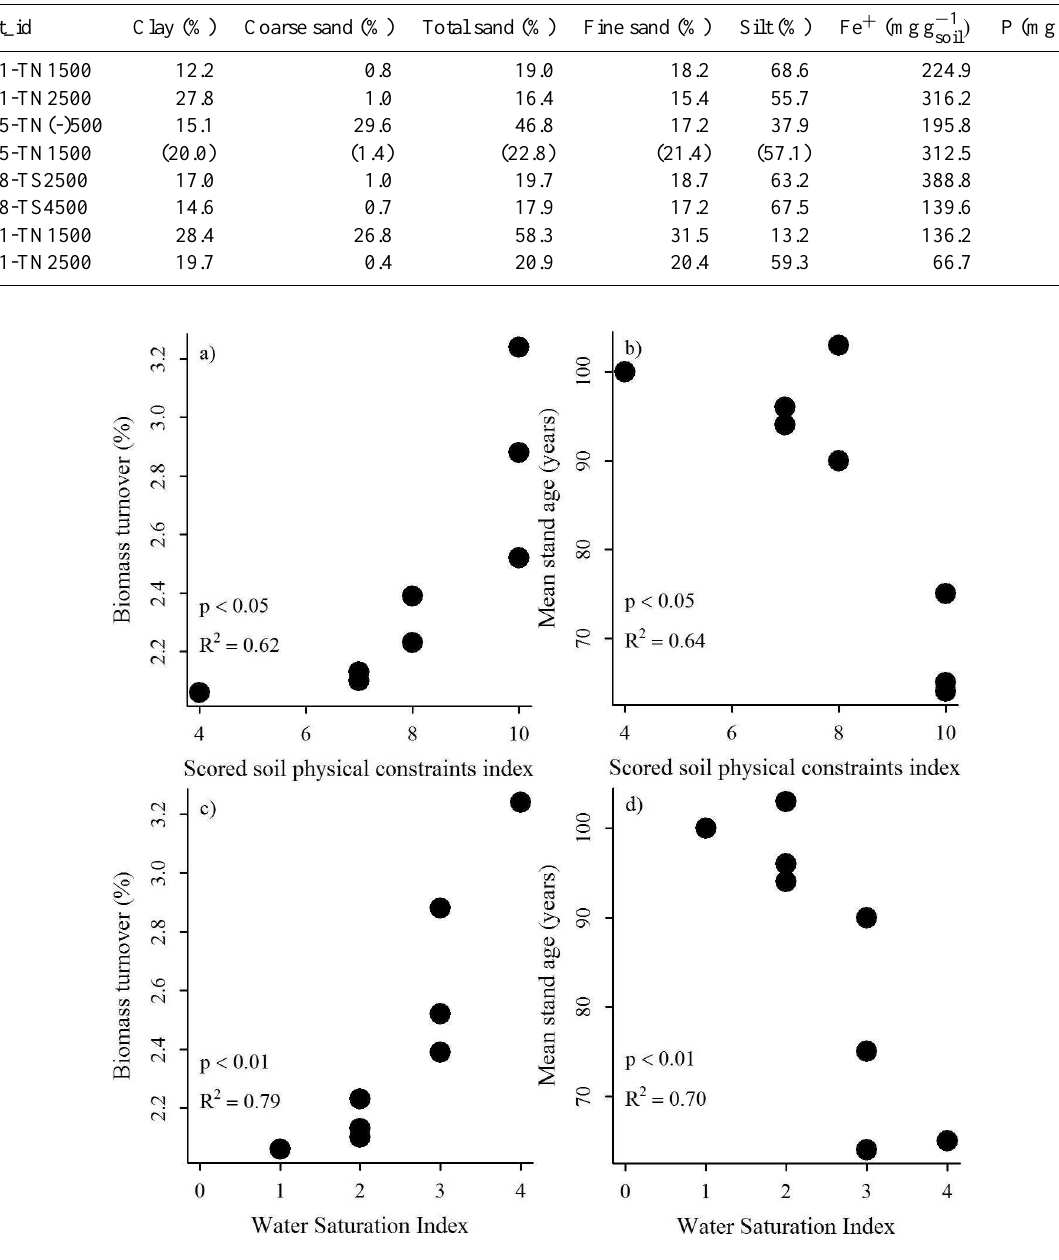
Fig. 5. Significant relations between the soil physical constraints index and (a) biomass turnover rates and (b) stand age, as well as the relation between soil water saturation index and (c) biomass turnover rates and (d) stand